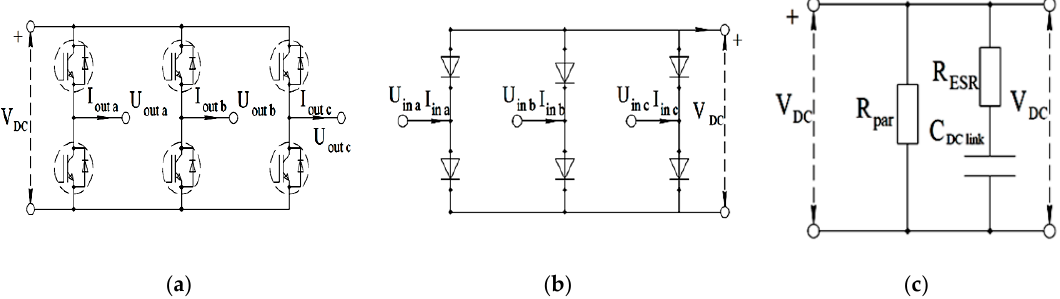
Figure 4. Electrical schemes of the models: ( a ) three-phase inverter; ( b ) three-phase uncontrolled rectifier (passive rectifier bridge); ( c ) DC-link.